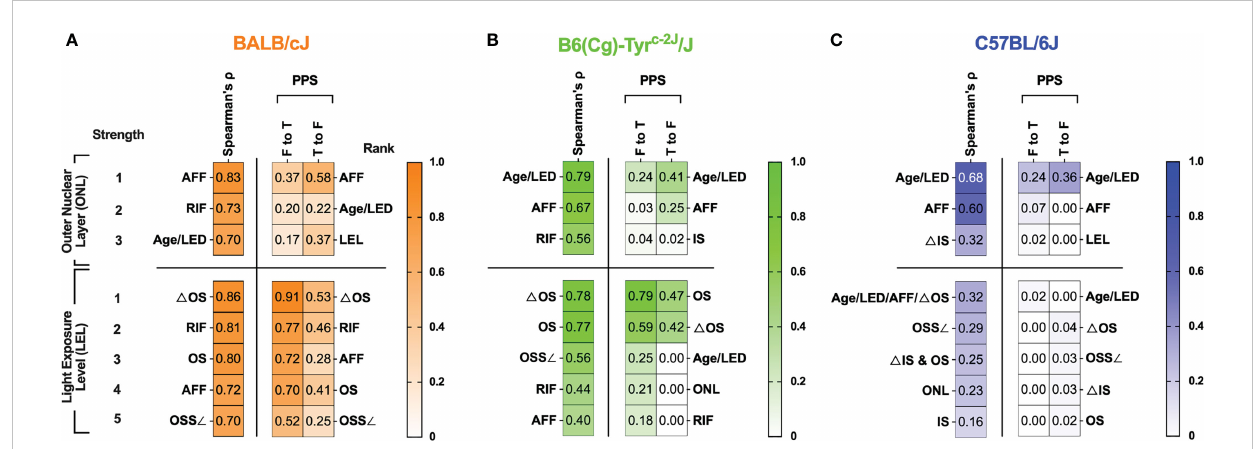
FIGURE 7 Summarized results of Spearman ’ s cross-correlation and PPS matrices related to Outer Nuclear Layer (ONL) thickness and Light Exposure Level (LEL) for BALB/c (A) , B6-albino (B) and B6 (C) mouse strains. Are any of the biomarkers capable of predicting retinal degeneration? For BALB/c mice, the best indicator for anticipating ONL thickness was AFF count. In both B6-albino and B6, animal Age and Light Exposure Duration (LED) was the best indicator of ONL thickness followed closely by AFF count. Thus, as an imaging biomarker, AFF was clearly the best indicator for determining whether ONL degeneration could be anticipated in a mouse eye. Are any of the biomarkers capable of revealing light-stress in an animal? For BALB/c and B6-albino mice, changes in the photoreceptor proximal outer segments observed by SD-OCT imaging are an excellent indicator of LEL, or light stress, in the vulnerable albino strains. D OS, which is simply the contrast between the proximal outer segments and the IS-OS transition zone appears to be the best method for indicating an animal under light stress from ~150-200 lx in both albino strains. Interestingly, this analysis has shown that D OS is an improvement over our original approach of using the outer segment signal slope (OSS ∠ ) as the best method to quantify this alteration in re fl ected